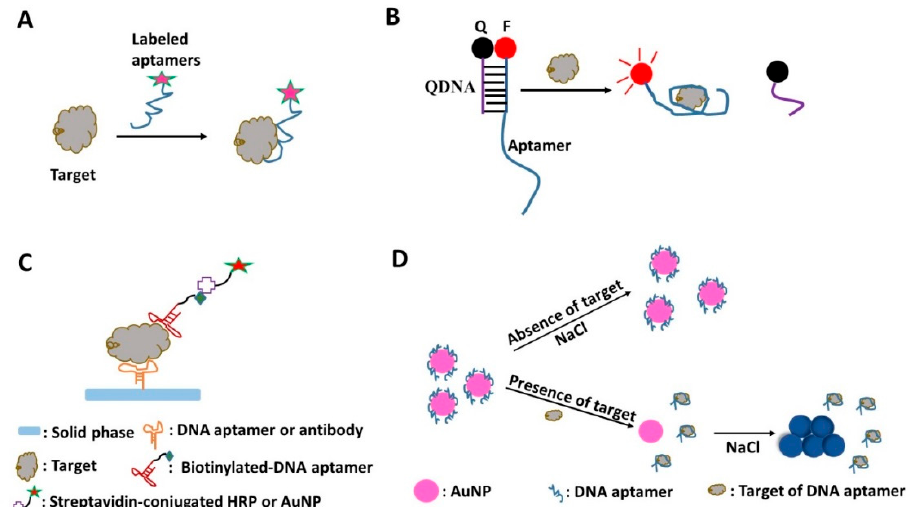
Figure 2. Scheme showing examples of the modes used in DNA aptamer-based detection. ( A ) Direct binding-based mode: The signal-molecule-labeled aptamers directly bind to the immobilized or free target. The signal molecules on the target are detected directly; ( B ) Target-induced structural switching mode: A fluorophore-labeled DNA aptamer forms a partial duplex with a small oligonucleotide modified with a quenching moiety (QDNA) in the absence of the target, bringing the fluorophore (F) and the quencher (Q) into close proximity for maximum fluorescence quenching. When the target is introduced, the aptamer prefers to form the aptamer-target complex. The binding of the target to the aptamer will change the structure of the aptamers and release the partially complementary quencher, which will trigger the increase of the signal; ( C ) Sandwich-like mode: The aptamer or antibody is immobilized on the solid phase as the capturer. The captured target is reported by the biotinylated aptamer, which displays the signal through further binding to the streptavidin-conjugated HRP or AuNP; ( D ) Target-induced dissociation mode: DNA aptamers coil around the surface of the gold nanoparticles (AuNPs) and stop the salt-induced aggregation of AuNPs. When the target appears, the DNA aptamers bind to the target and release from the AuNPs. The AuNPs without the cover of aptamers aggregate in the salt solution and change color from red to purple.